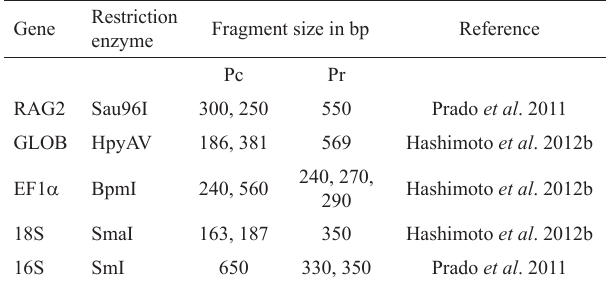
Table 2. Description of restriction enzymes and size of the fragments in base pairs (bp) generated by restriction enzyme digestion. Pc: Pseudoplatystoma corruscans , Pr: Pseudoplatystoma reticulatum